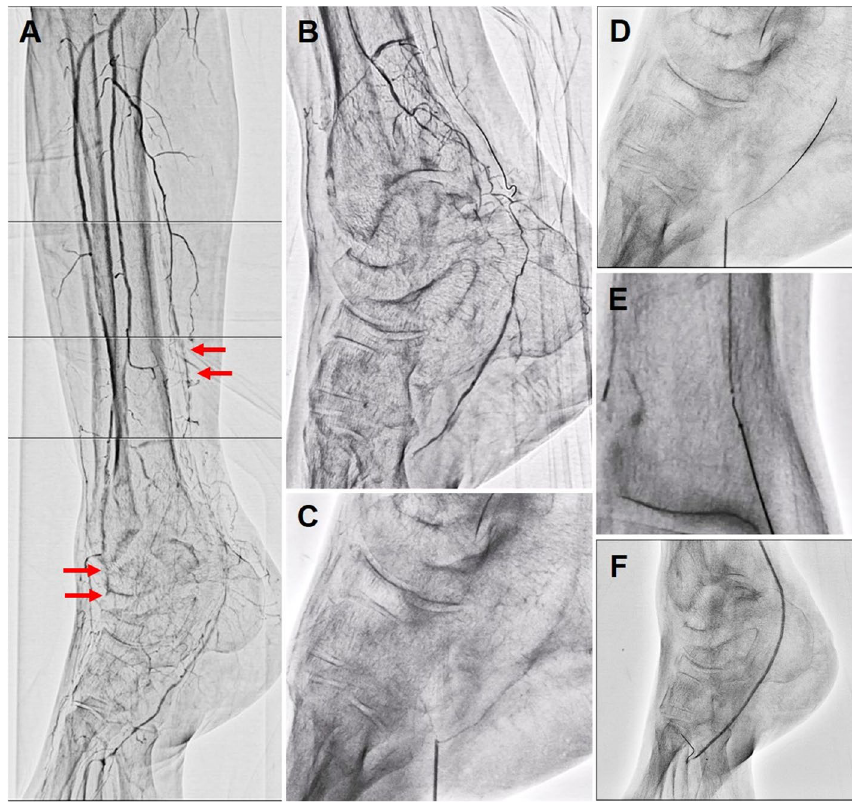
Fig. 1 a Initial angiography showing occlusions of the distal anterior tibial artery (ATA) and mid posterior tibial artery (PTA) with severe calcification (Arrows). b The lateral plantar artery was perfused by collateral blood flow from the peroneal artery. c First distal puncture of the lateral plantar artery with angiographical guidance. d Gladius MG guidewire advancement into the lateral plantar artery. e Retrograde guidewire insertion into the antegrade microcatheter. f Successful balloon angioplasty of the occluded